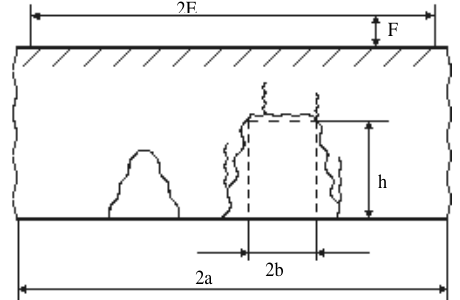
Fig 6. Computational model of subsurface hydrogen corrosion